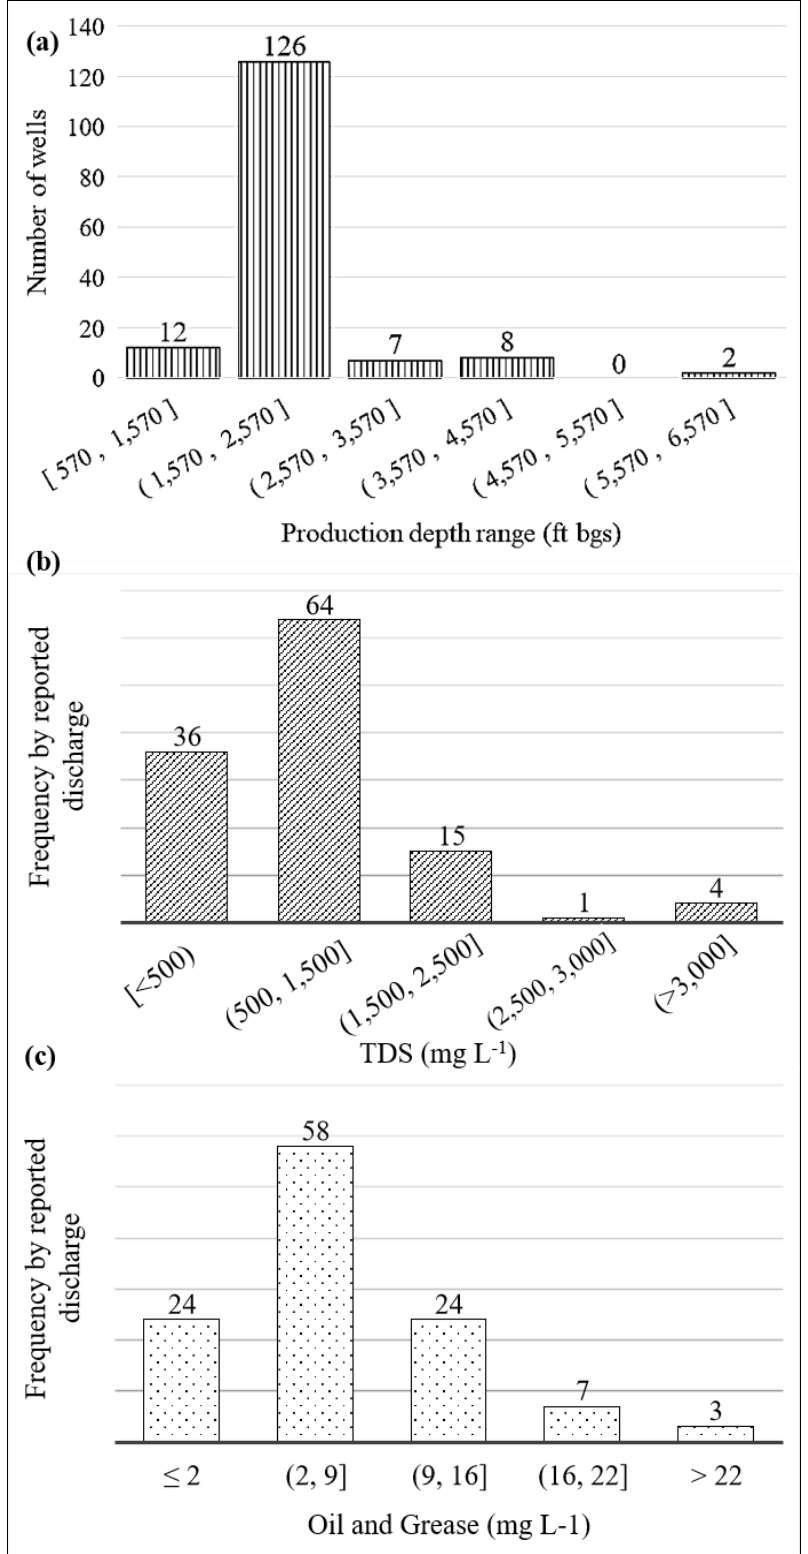
Figure 6. Frequency of occurrence of (a) wells per producing depth range, (b) total dissolved solids (TDS) level distribution based on reported water quality data per year, and (c) oil and grease level distribution based on reported water quality data per